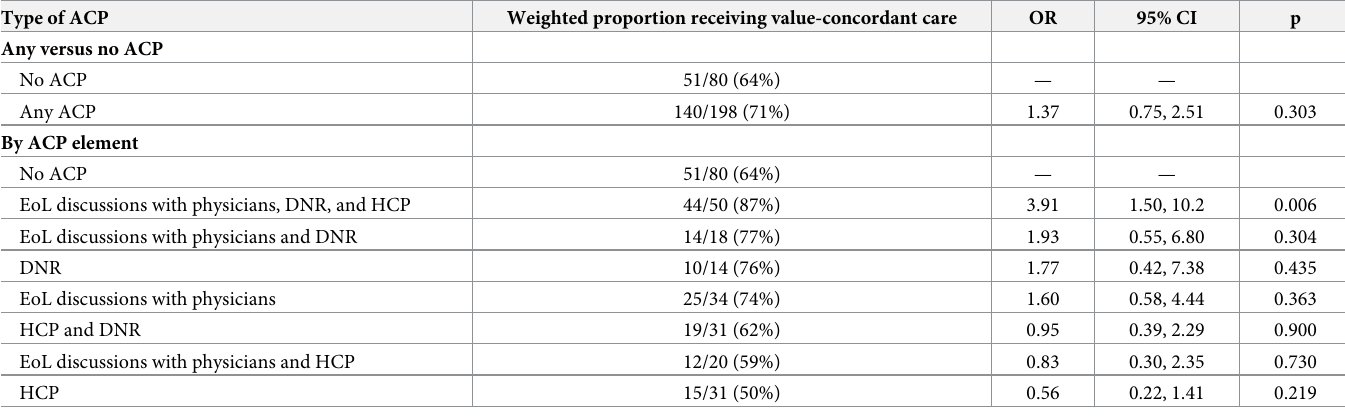
Table 2. Odds of receiving value-concordant care by type of ACP (N = 278).